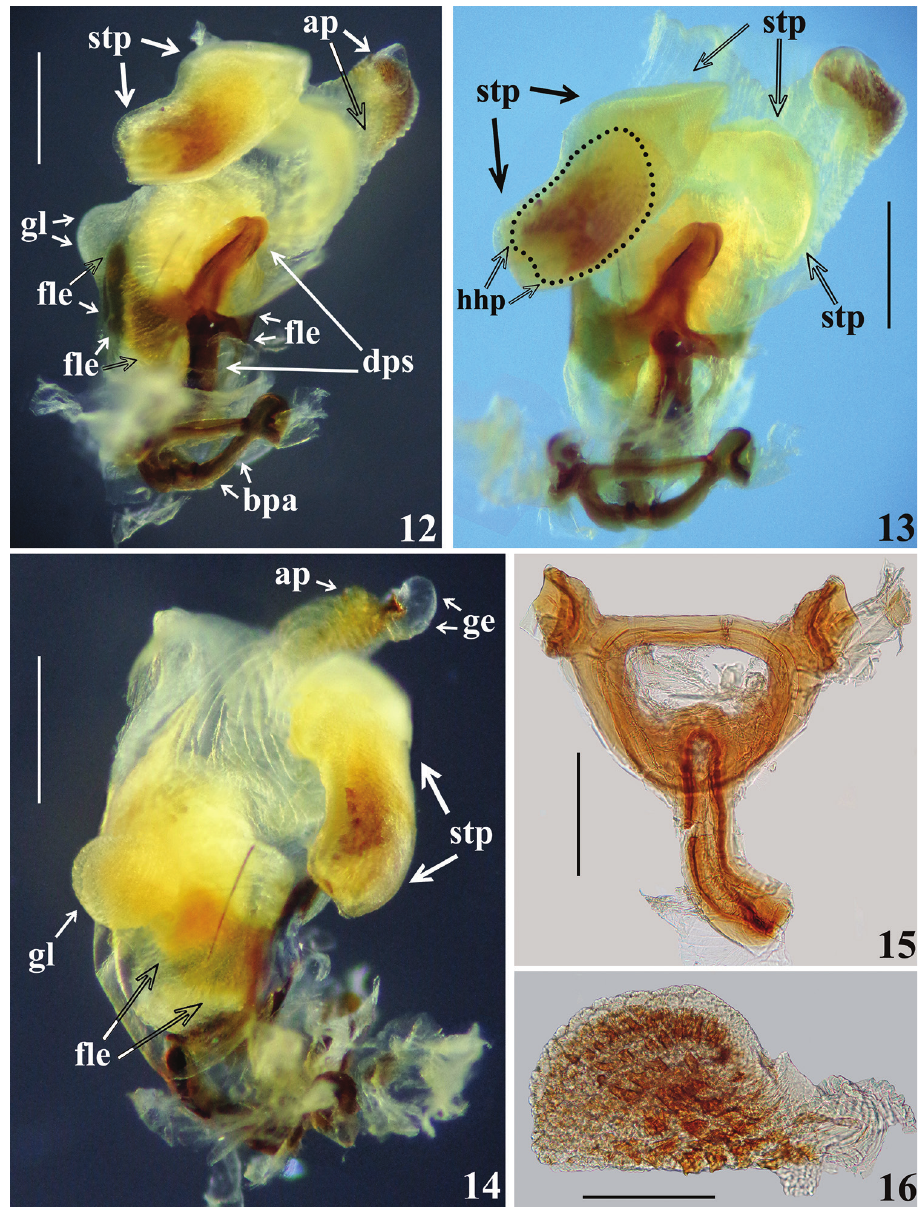
sal view 14 lateral view 15 articulatory apparatus and pedicel 16 half-hemispherical process. ( ap apical process of endosoma; bpa basal plate arm; dps dorsal phallothecal sclerite; fle flat lateral expansion; ge globose expan- sion of endosoma; gl small lateral globose lobe of endosoma wall; hhp half-hemispherical process; stp subapical tubular projection of endosoma wall). Scale bars: 0.5 mm ( 12–14 ); 0.3 mm ( 15–16